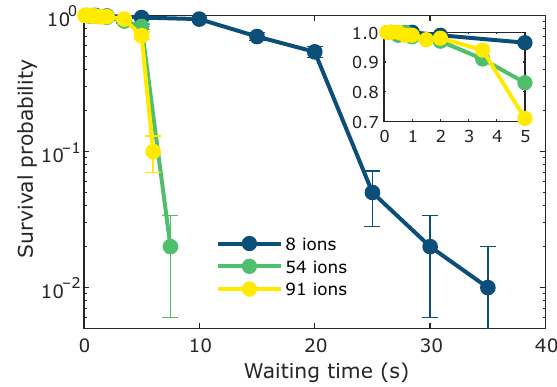
FIG. 4. Melting behavior of planar crystals. Shown here is the probability that a crystal consisting of a certain number of ions has not melted into a cloud after a waiting time without any laser cooling. For each data point, 100 experiments are performed. The inset shows the probabilities for short waiting times in more